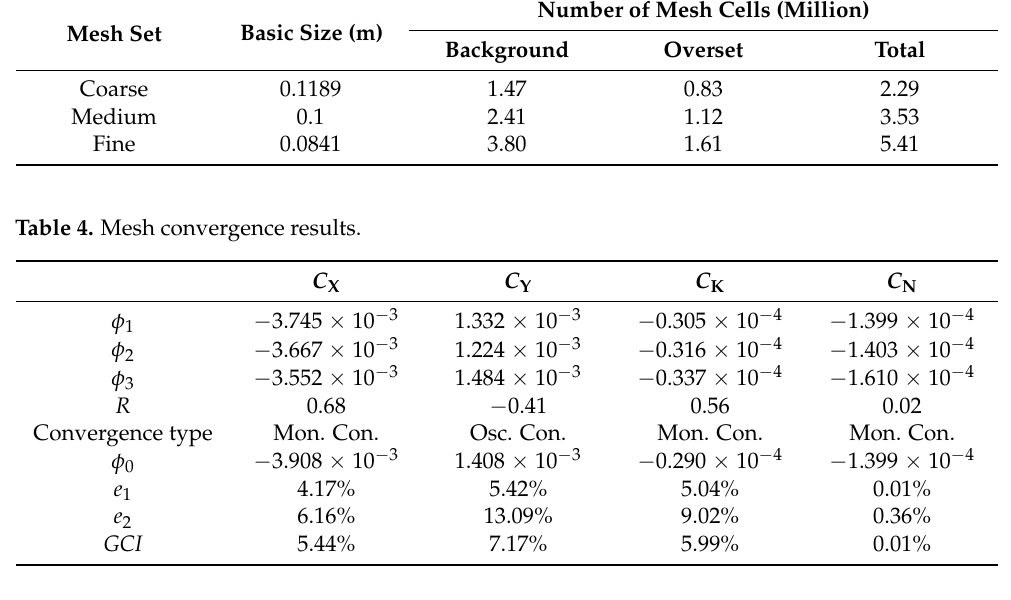
Table 3. Mesh configurations.